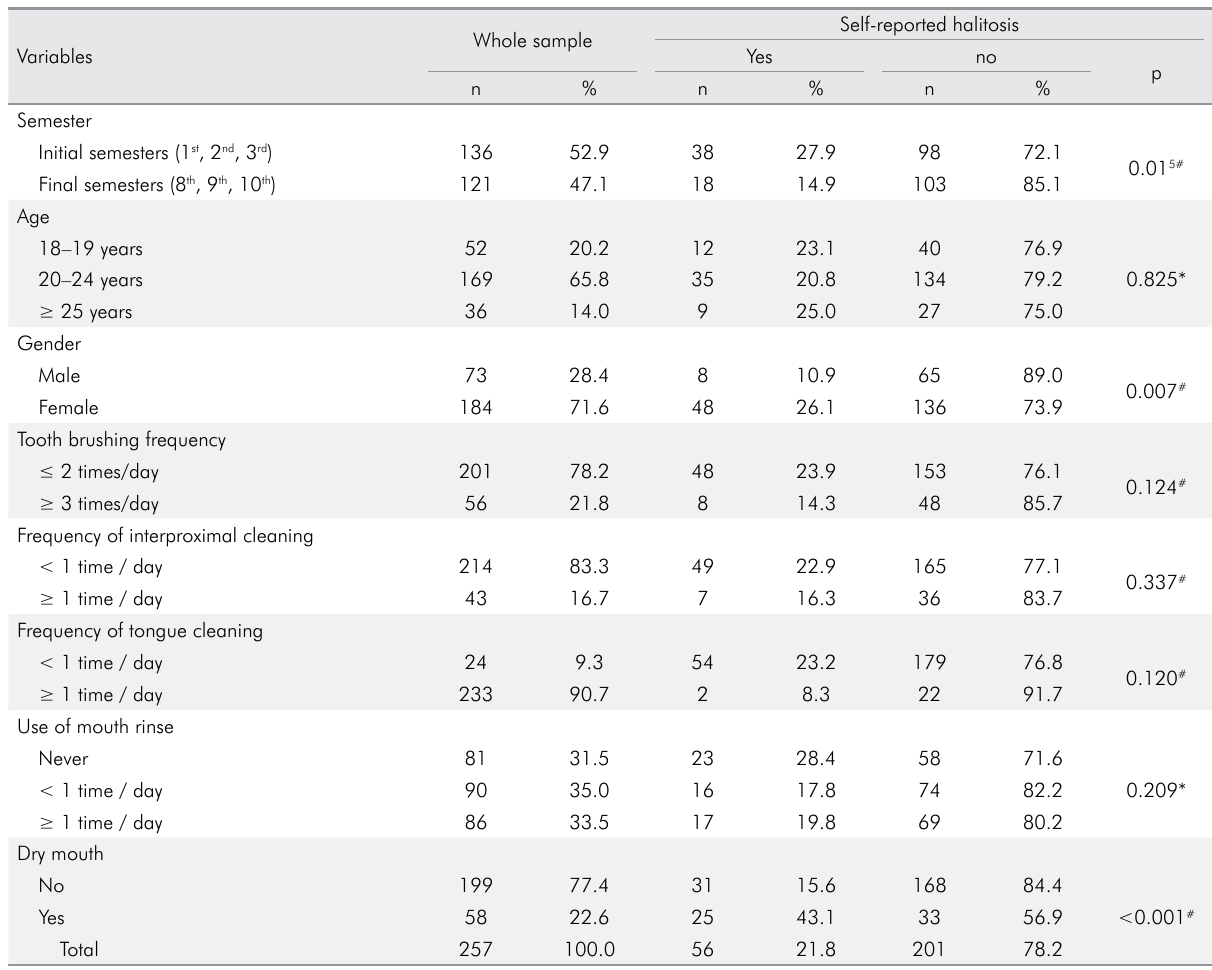
Table 1. Characteristics of the sample of the